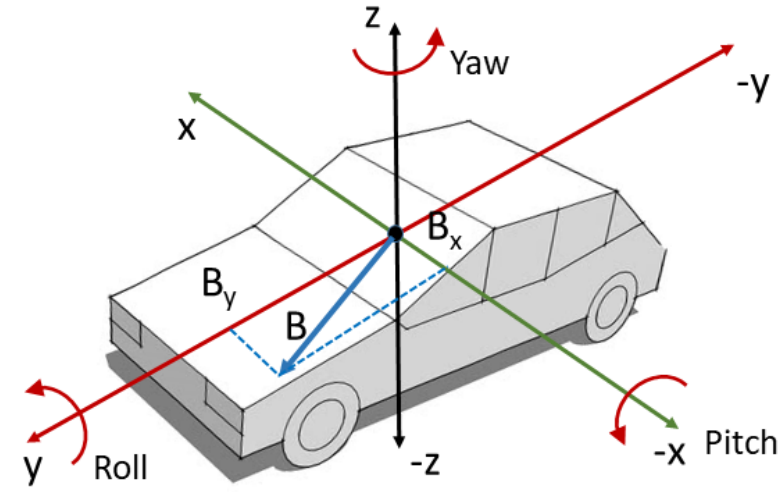
Figure 2. Motion sensor orientations with respect to the vehicle. Vector B represents the direction of Earth’s magnetic